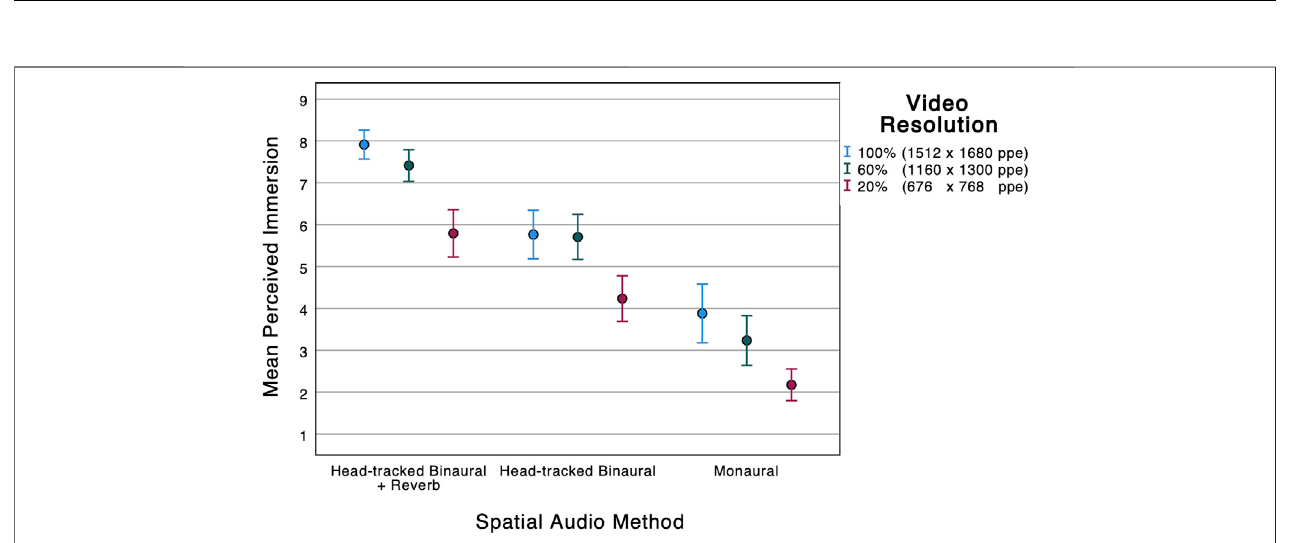
FIGURE 2 | Mean perceived immersion against video resolution and spatial audio method. The error bars represent the 95% con fi dence intervals.